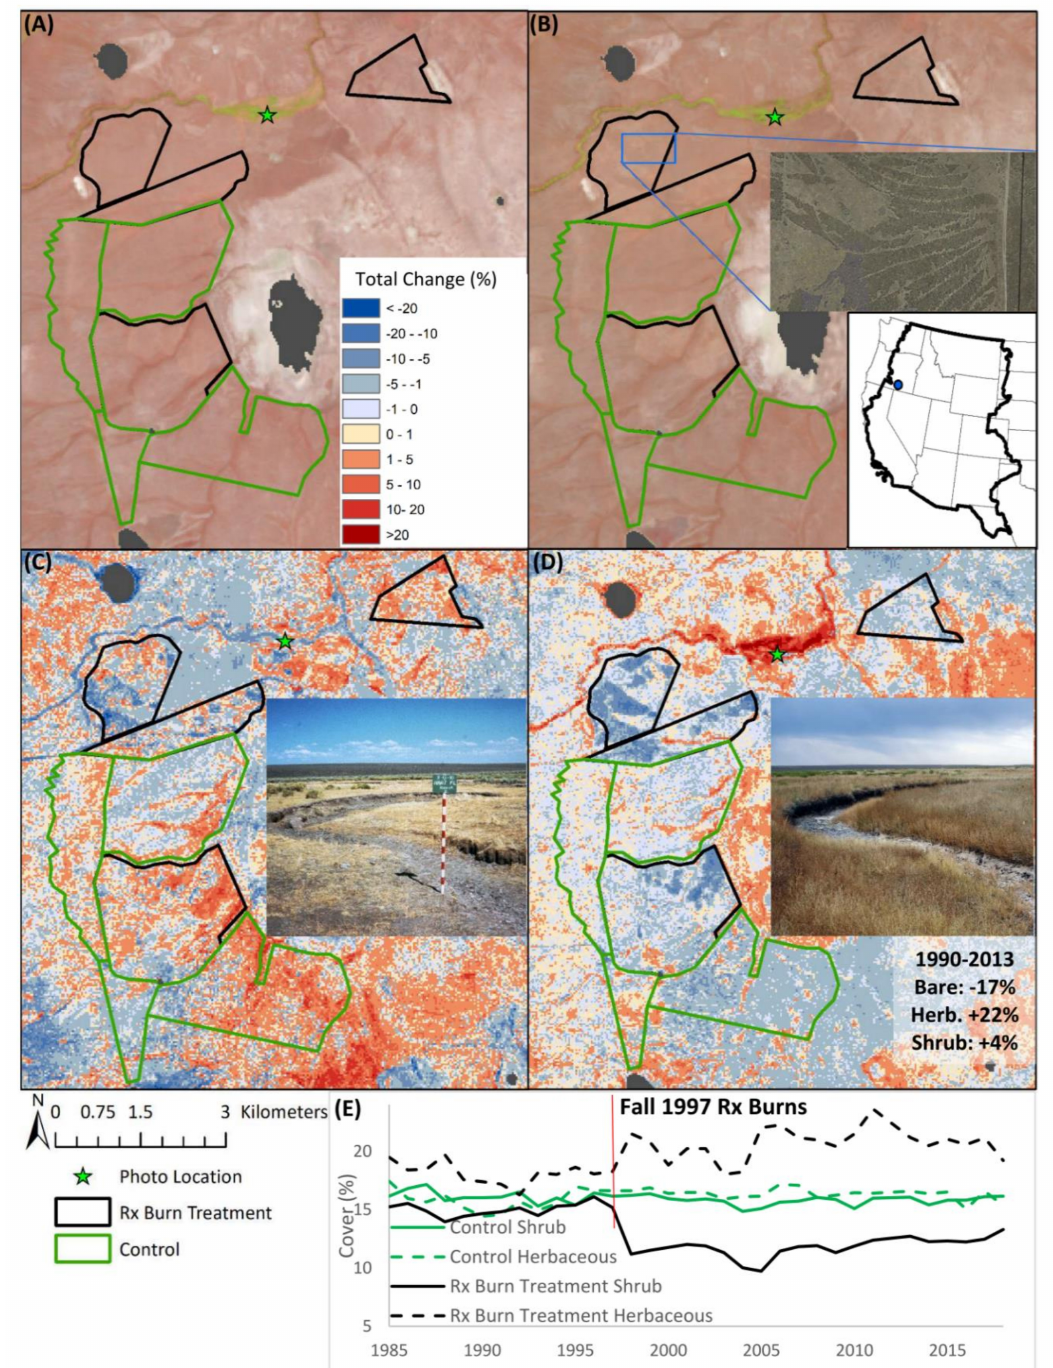
Figure 7. Component change related to experimental prescribed ( Rx ) burn and control treatments conducted by Ellsworth et al. [21] and altered management in Hart Mountain National Antelope Refuge, Oregon related to the re- moval of domestic livestock and wild horses [22]. ( A ) Landsat Image from 8 August 1997, ( B ) Landsat image from 12 July 2018, with inset Google Earth image from 5 September 2014, showing the heterogeneity in a burn severity in a treatment pasture 17 years after fire, and a second inset with the case study location, ( C ) temporal slope of bare ground from 1985 to 2018, inset is plot photo from 15 August 1990, ( D ) temporal slope of shrub cover from 1985 to 2018, inset is plot photo from 8 August 2013, with text below showing change in fractional component cover in the pixel representing the photo location, ( E ) mean annual herbaceous and shrub cover in Rx burn and treatment pastures. For C and D , refer to Figure 3 for interpretation of slope symbology. Photo credit